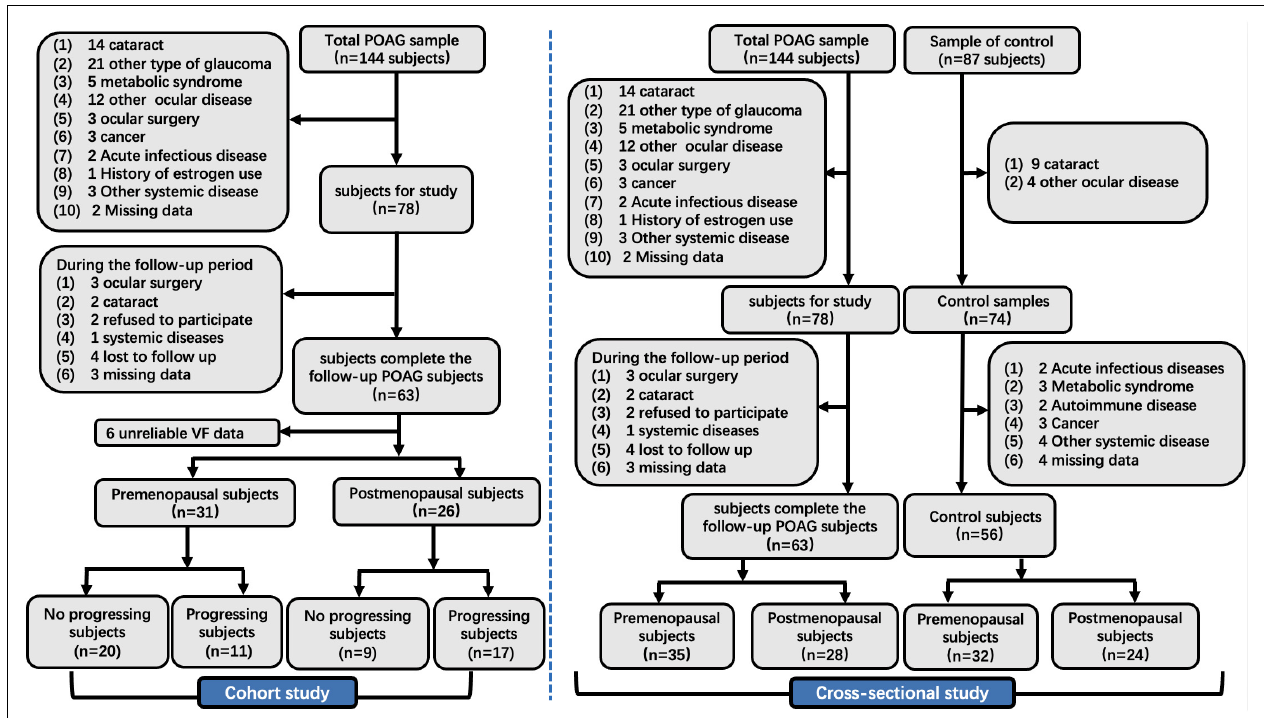
FIGURE 1 | The flow chart of the cross-sectional and cohort study. POAG, primary open angle glaucoma; IOP, intraocular pressure; VCDR, vertical cup-to-disk ratio; VF, visual